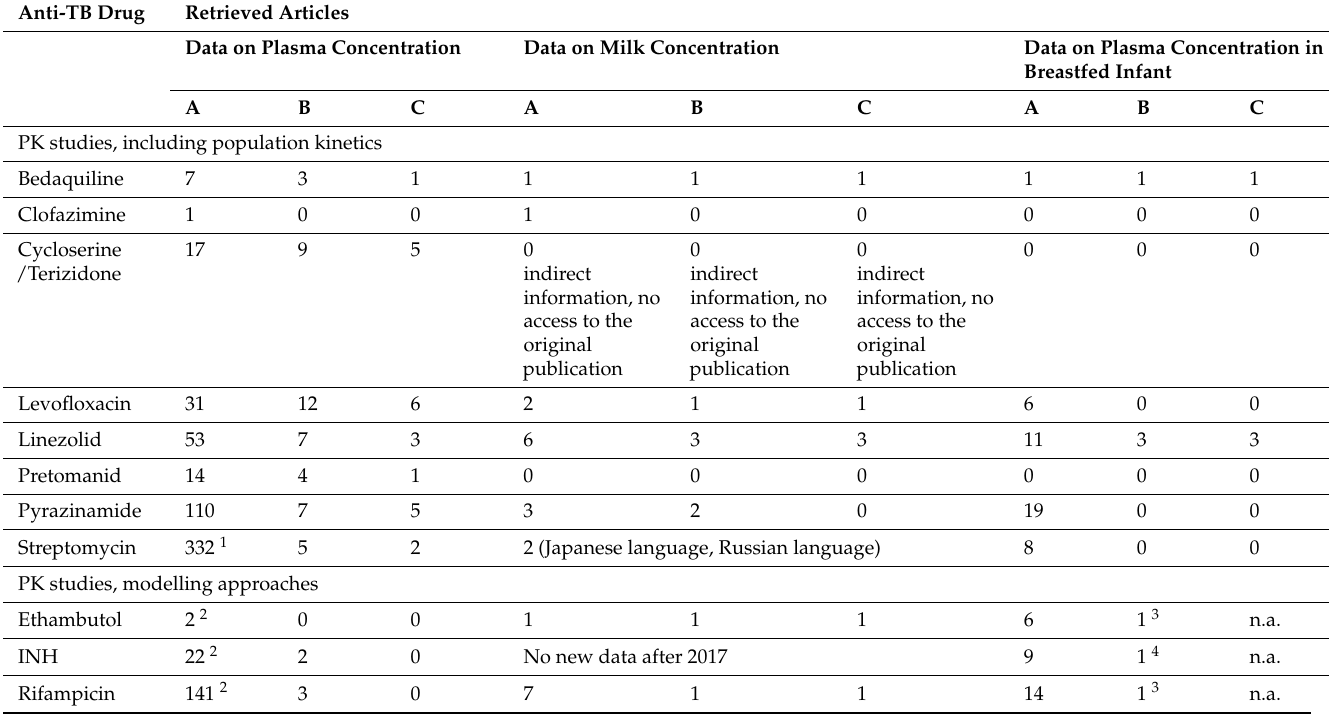
Table 1. Overview on (A) number of articles found in the search, (B) number of articles remaining after title and abstract screening and (C) number of articles remaining after full text